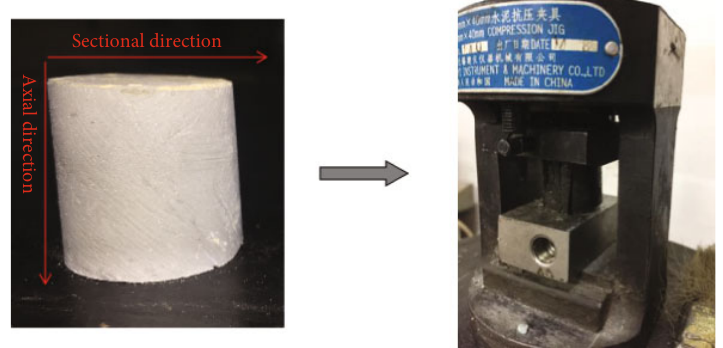
Figure 3: Illustration of spatial direction of cement-based